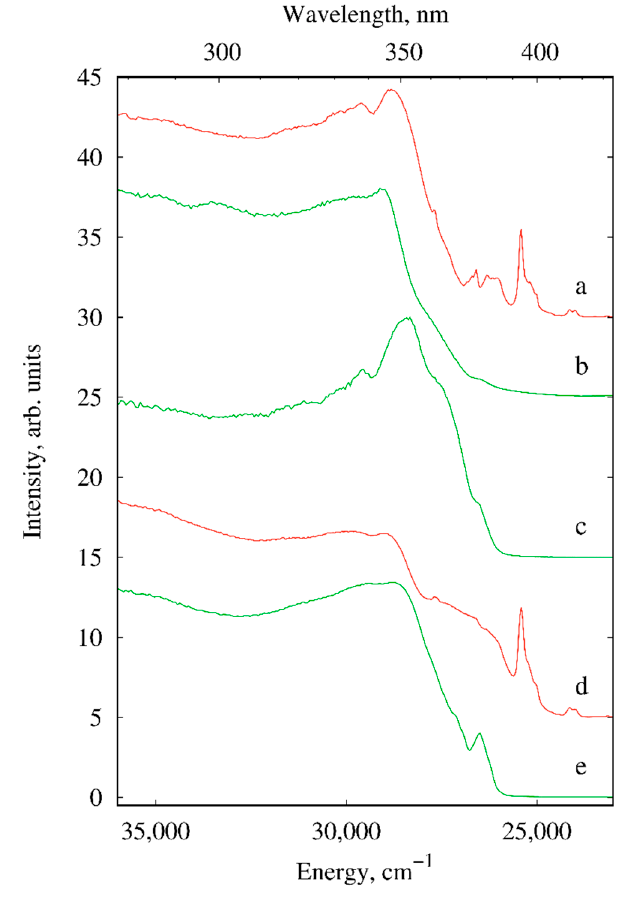
Figure 8. Excitation spectra of I ( a ), III ( b ), V ( c ), VI ( d ) and VIII ( e ) (solid samples, λ em = 615 nm (for Eu 3+ compounds) and 545 nm (for Tb 3+ compounds), T = 300 K).